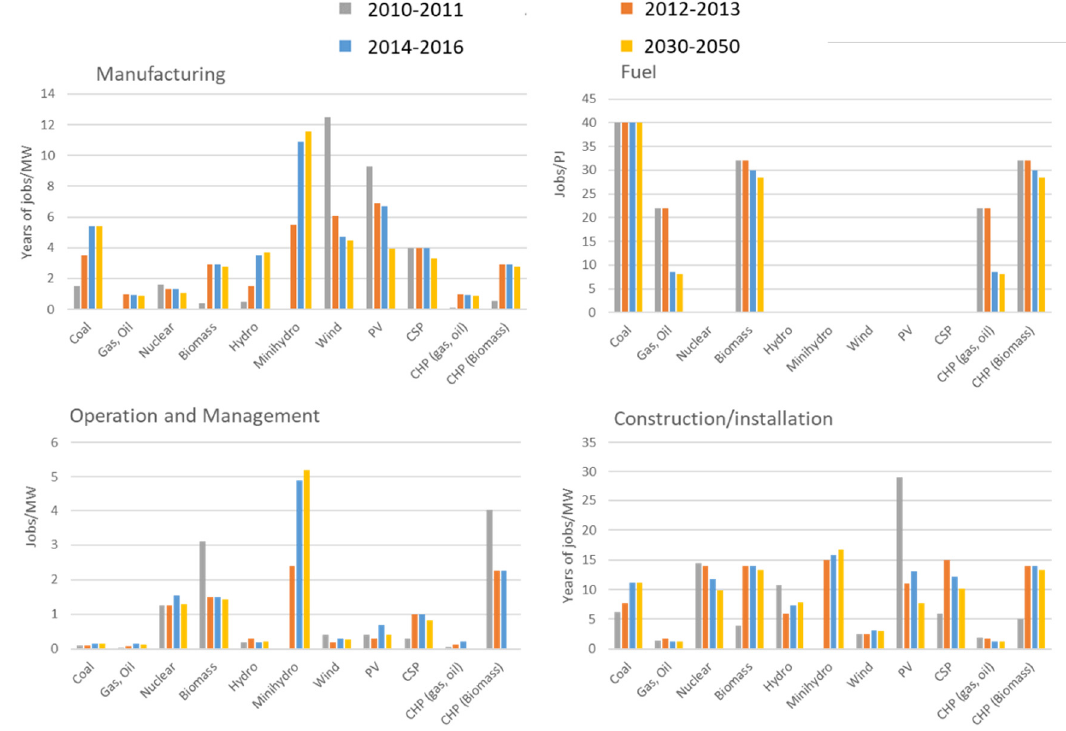
Figure 7. Employment factors used to quantify direct jobs created from different power generation technologies (adapted from [21,38,39]).